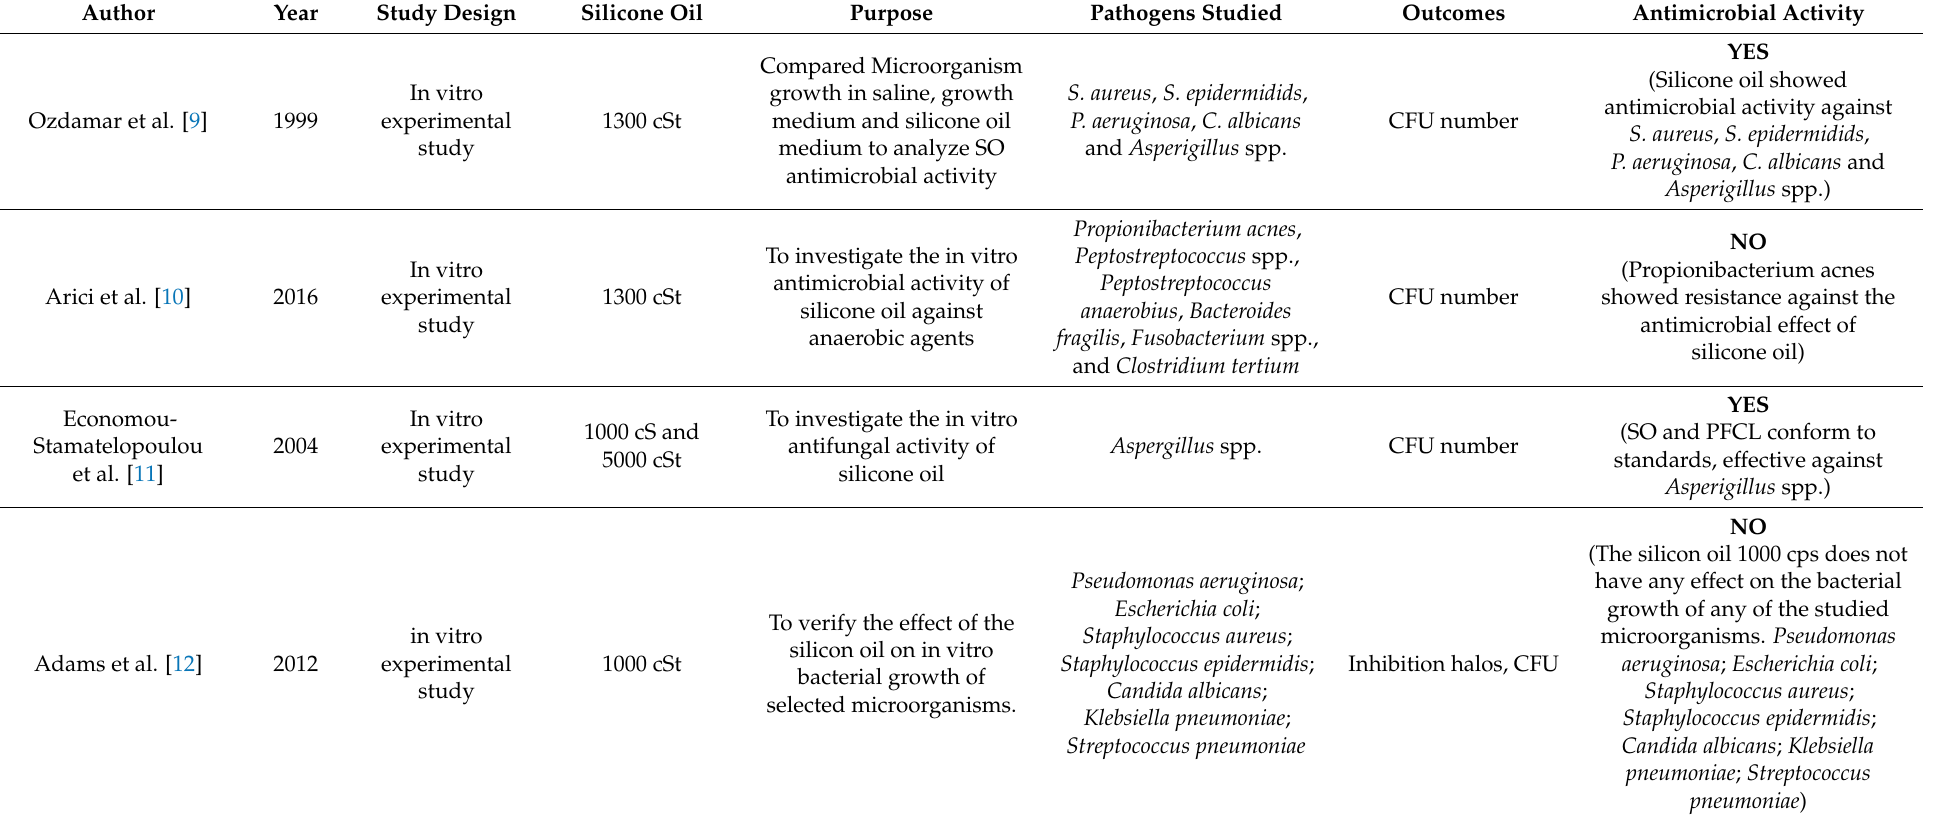
Table 1. Does silicone oil have antimicrobial